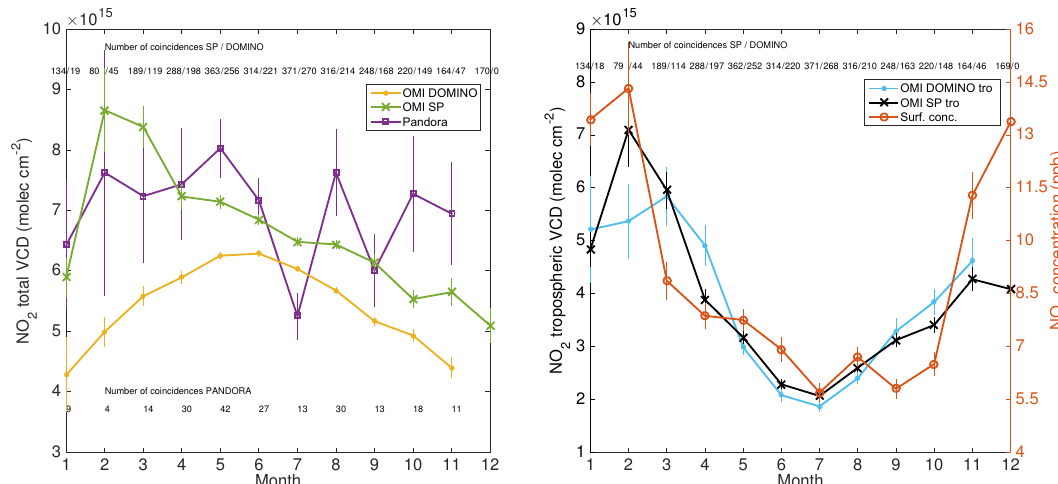
Figure 5. Left: NO 2 seasonal cycle from total columns from OMI SP and DOMINO (yellow) products during the period 2006–2014. The monthly means from collocated Pandora NO 2 total columns measured in Helsinki during 2012 are also shown (purple). Right: NO 2 seasonal cycle from tropospheric (tro) columns from OMI SP (black) and DOMINO (light blue) products. The seasonal cycle of the NO 2 surface concentrations measured in Kumpula air quality station is also shown in red. Note that VCDs (vertical column densities) and surface concentrations are reported on the left (moleculescm − 2 ) and right (ppb) y axis, respectively. The number of coincidences between OMI and the closest surface concentration measurement within 30min is shown for each month on the top of both panels for both SP and DOMINO. The number of coincidences for the subset of Pandora observations is reported at the bottom of the left panel. The ground- based observations are sampled according to SP NO 2 products. The error bars are estimated from the standard deviation of the mean. Only collocated observations with OMI CF < 0.5 are taken into